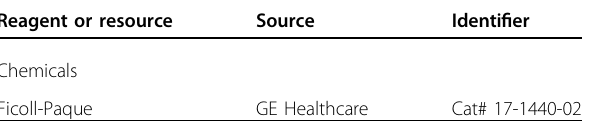
Table S1. This study was under the tenets of the Declaration of Helsinki and was approved by the Medical